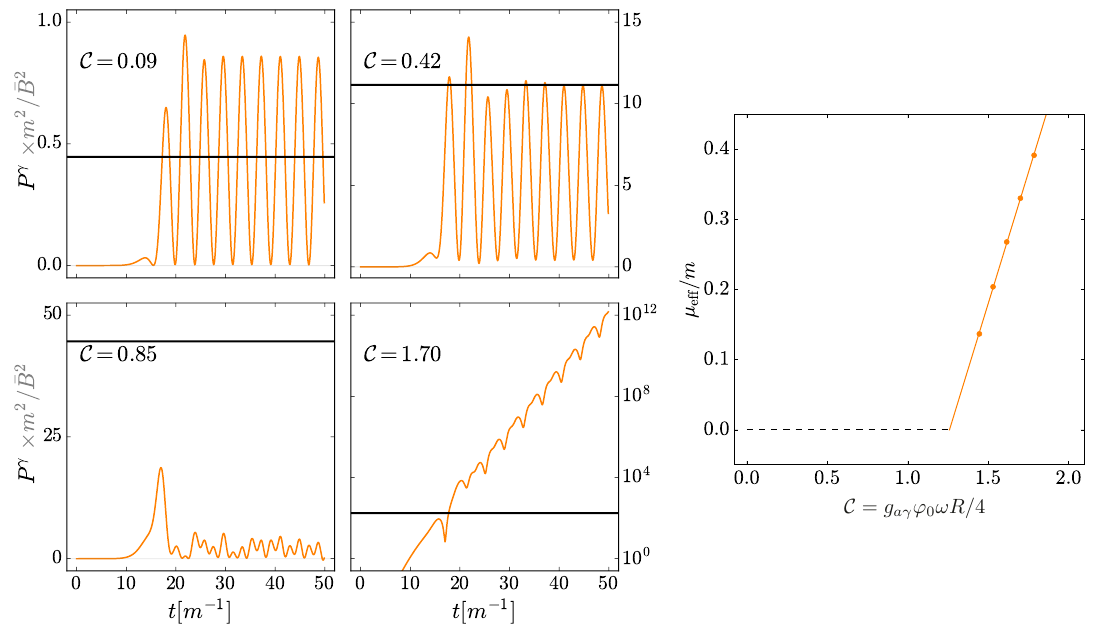
Figure 5 . (Left) The radiated power versus time for the different effective dimensionless coupling C = g aγ ϕ 0 ωR/ 4 = 0 . 09 , 0 . 42 , 0 . 85 and 1 . 7 due to a dense soliton in a constant magnetic field background. Notice on the last plot (lower right) the logarithmic vertical scale and the unbounded solution, while the other three are bounded. (Right) The exponent µ extracted from the expo- eff nential growth of the radiated power. There exists a linear relationship between µ and C in the eff unbounded region. The C 1 . 3 can be read off as the zero point of the linear relationship, critical ≈ with µ 0 . 75 C . We caution that the precise numerical coefficients depend on the details of eff /m ≈ the soliton configuration. For the above plots we are dealing with a dense soliton ϕ and 0 ∼ f R ∼ few × m − 1 and ω . m